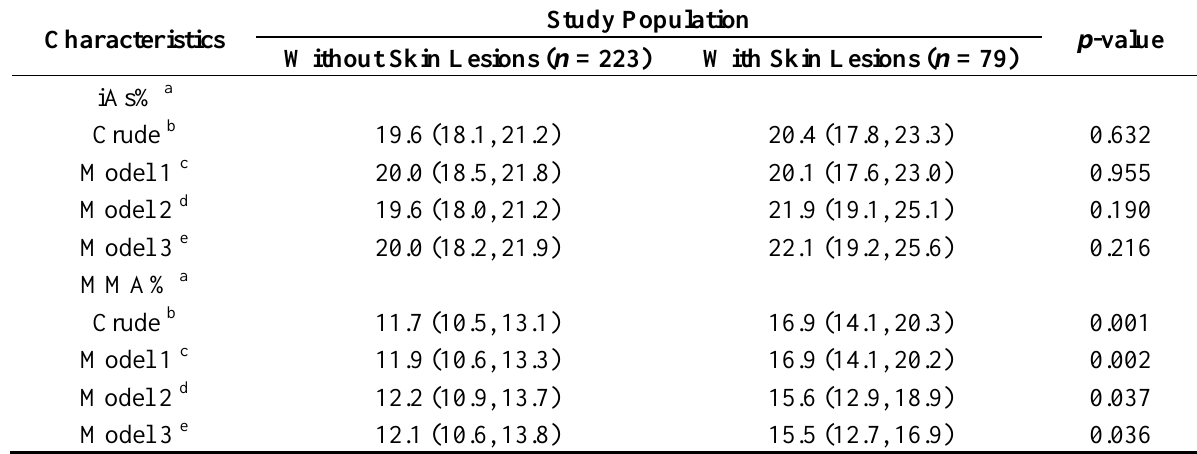
Table 4. Differences of adjusted means of urinary arsenic methylation indices between subjects with and without skin